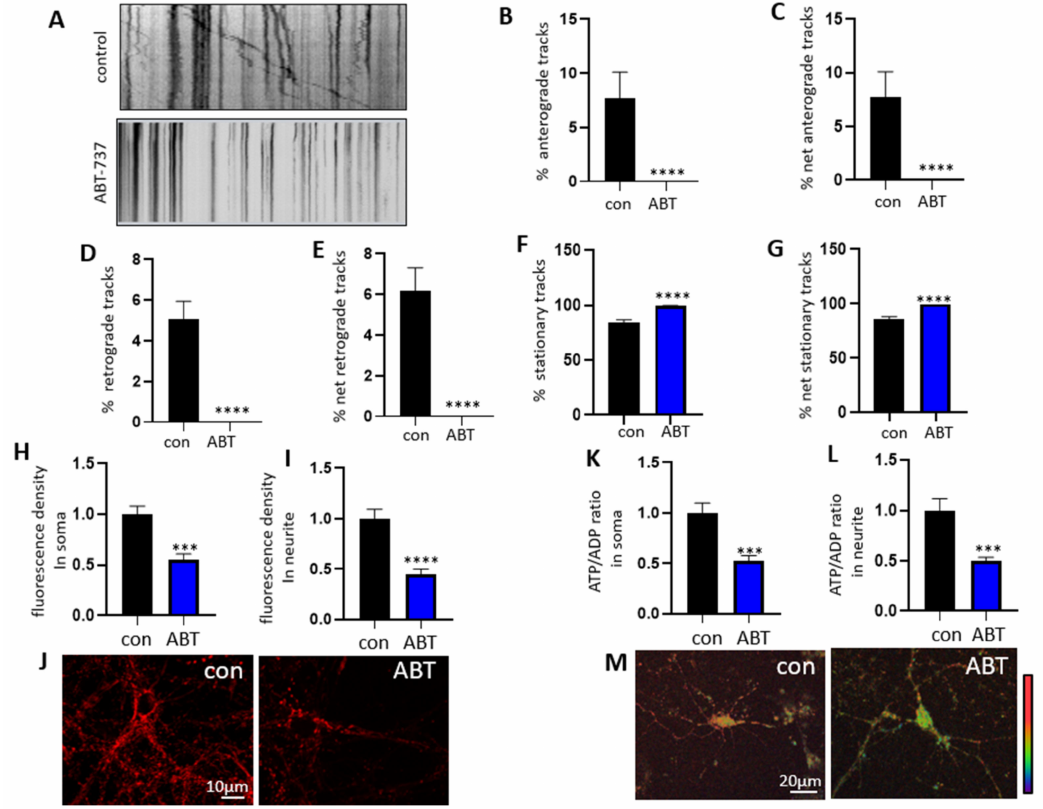
Figure 3. Treatment with ABT-263 impairs mitochondrial motility in primary hippocampal neurons. Primary hippocampal neurons were treated with or without ABT-263 (1 µ M). Neurons treated with ABT-263 were analyzed using the Kymo- Analyzer ( A ) and the following metrics were generated: % anterograde ( B ), n = 57, **** p < 0.0001, Mann–Whitney test, % net anterograde ( C ), n = 57, **** p < 0.0001, Mann–Whitney test, % retrograde ( D ), n = 48, **** p < 0.0001, Mann-Whitney test, % net retrograde ( E ), n = 48, **** p < 0.0001, Mann–Whitney test, % stationary ( F ), n = 48, **** p < 0.0001, Mann– Whitney test, and % net stationary tracks ( G ), n = 48, **** p < 0.0001, Mann–Whitney test. Neurons were treated with TMRM and fluorescence density was measured ( H – J ), n = 12. *** p < 0.001, and **** p < 0.0001, two-tailed Student’s t -test. Scale bar = 10 µ m. ( K – M ), The PercevalHR Sensor (F 488nm /F 405nm ) was applied and psuedocolour ratiometric microgaphs were used to indicate the ATP/ADP ratio ( n = 12). *** p < 0.001, two-tailed Student’s t -test. Red, higher ATP/ADP; Blue, lower ATP/ADP. Scale bar = 20 µ